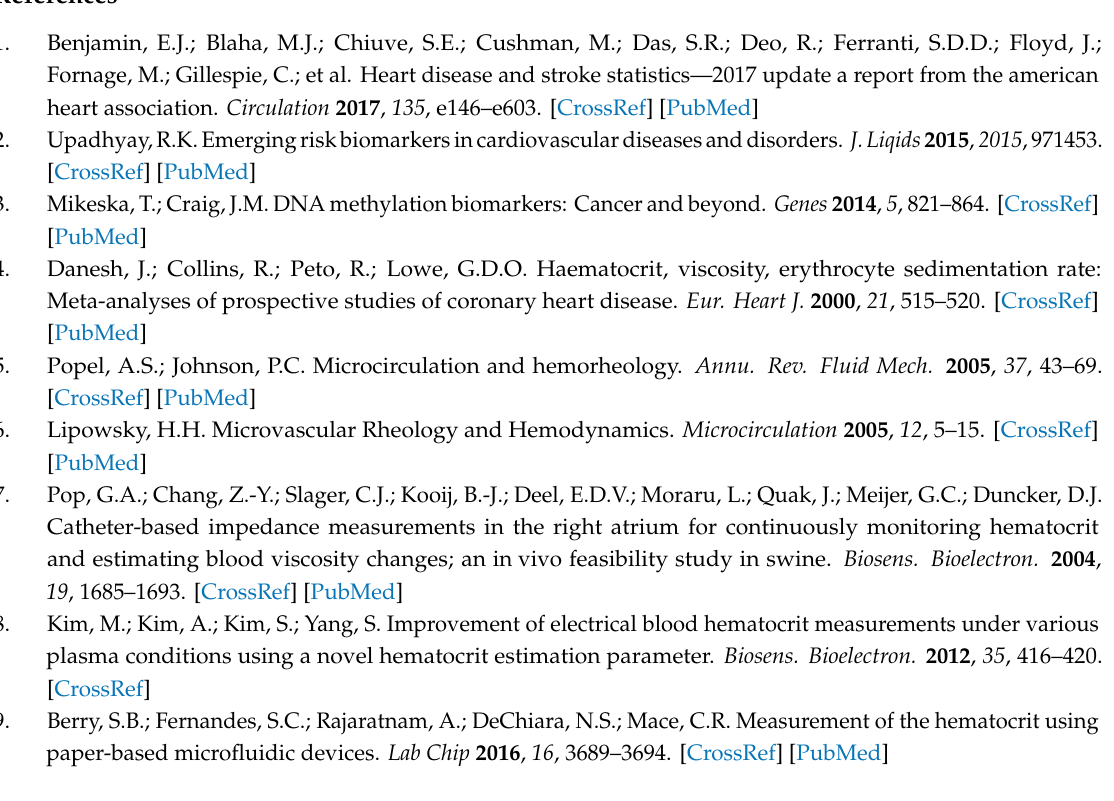
Figure S1: quantification of blood viscosity composed of RBCs hardened with GA solution, and Figure S2: validation of blood flow rate obtained by conducting